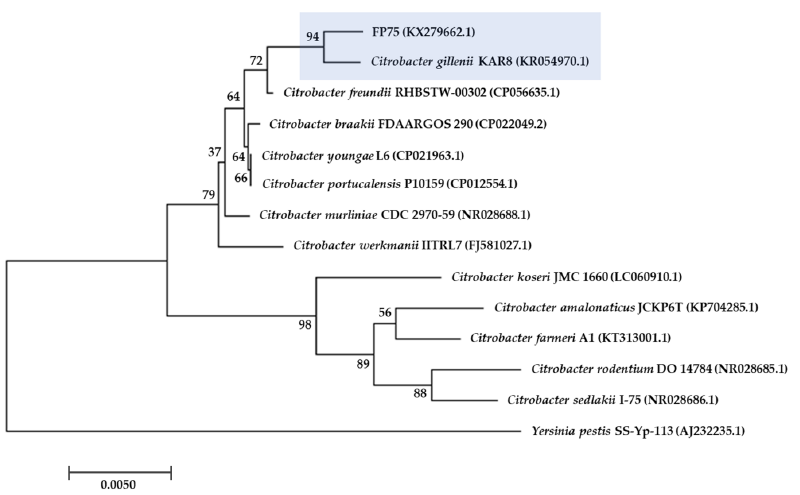
Figure 1. Phylogenetic tree based on the 16S rDNA gene sequence constructed by the neighbor-joining method. Yersinia pestis was used as an outgroup. Horizontal branch lengths are proportional to evolutionary divergences. Bootstrap values (%) appear next to the corresponding branch.